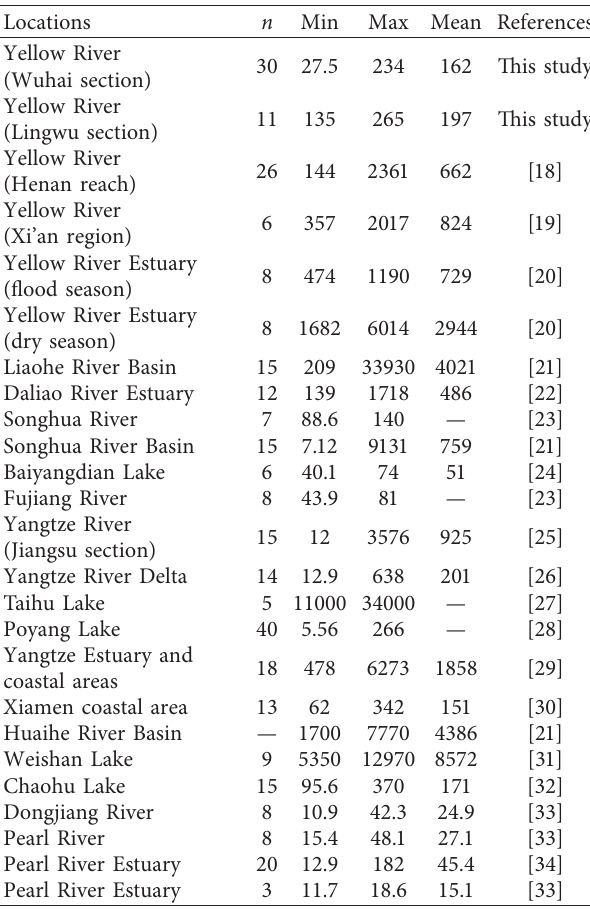
Table 1: Summary of concentrations (ng/L) of PAHs in surface water samples collected from rivers in China during the past decade.